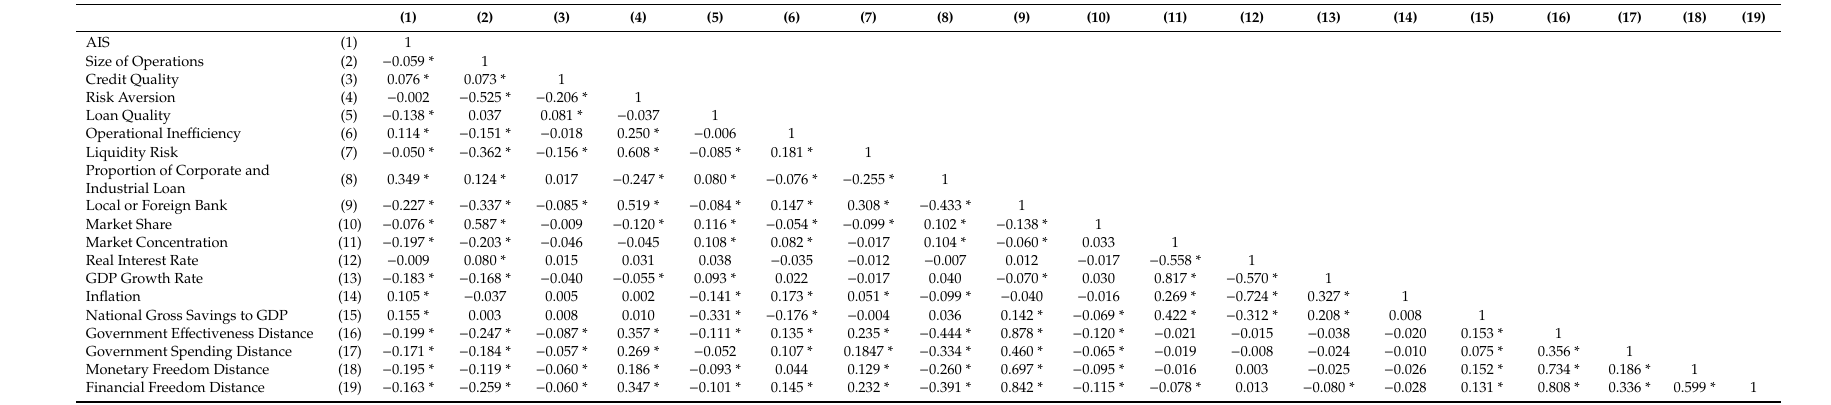
Table 3. Correlation coe ffi cient between